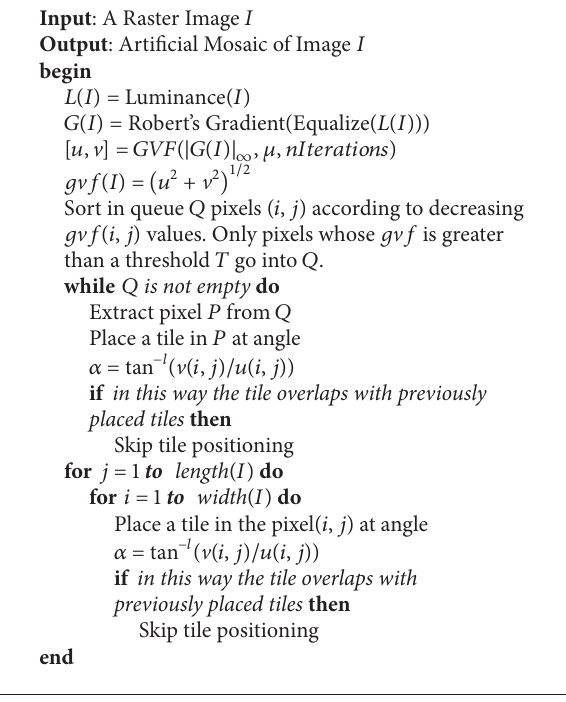
Algorithm 1: Mosaic generation algorithm.